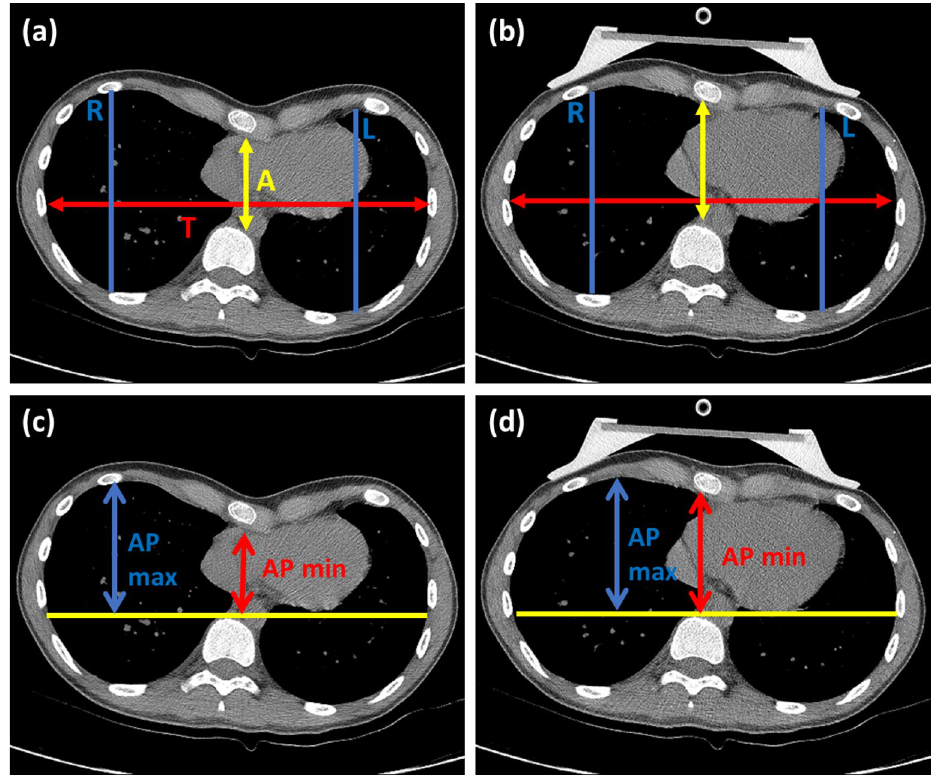
Figure 2. Measurement of asymmetry index (AI) and correction index (CI) using chest computed tomography (CT). ( a ) Measuring AI before applying vacuum bell (VB) device: The largest sagittal distance of the right (R) and left (L) chest at the same slice on chest CT as that used for HI was used in the formula was AI = R/L, where T is the greater transverse diameter and A is the shortest distance between the vertebrae and sternum. AI > 1.0 implies right asymmetry, while AI < 1.0 indicates left-skewed PE ( b ) Measurement of AI during application of a VB device: Assessments were performed using the chest CT slice as that used before. ( c ) Measuring CI